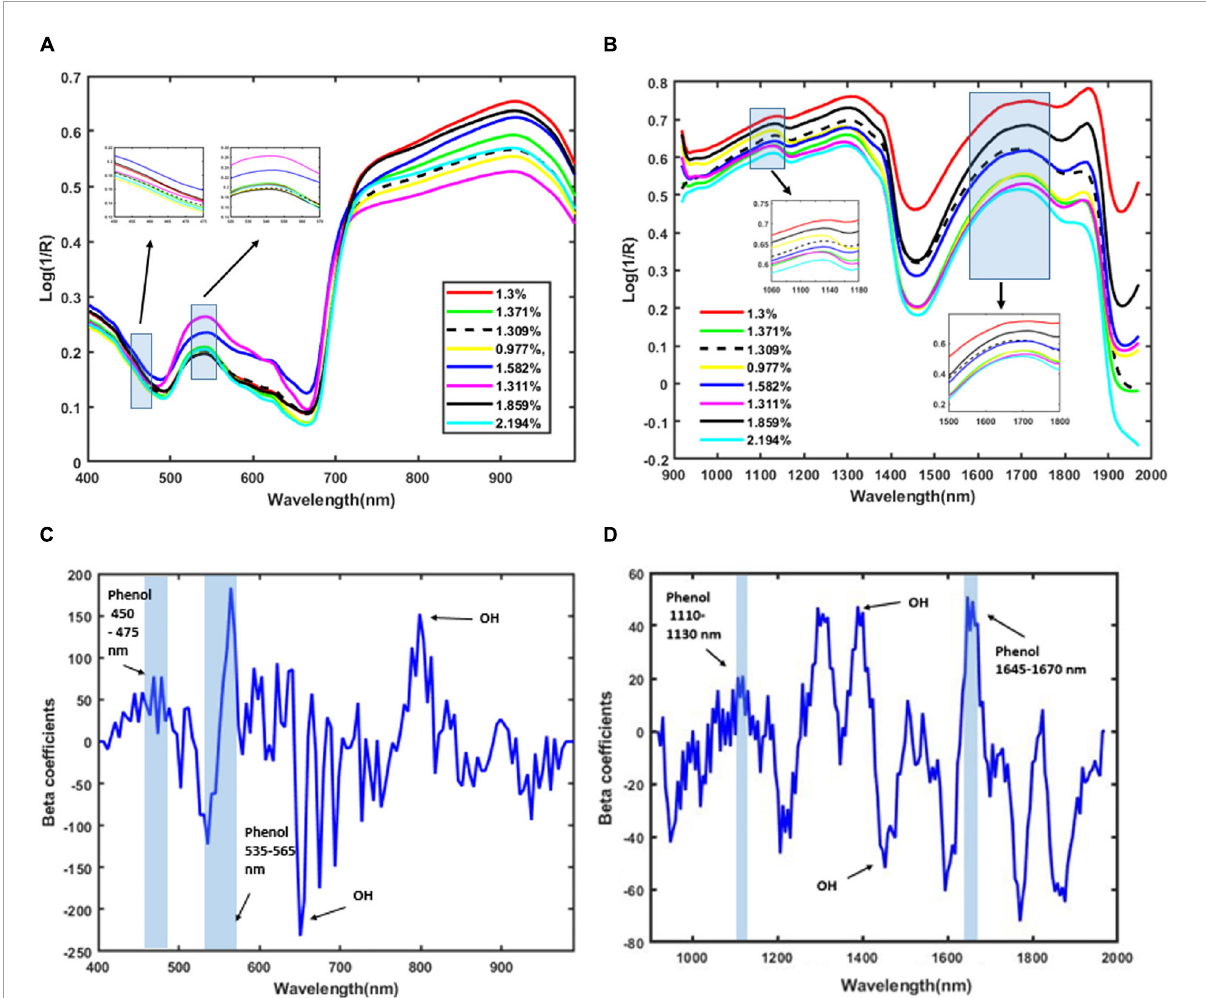
FIGURE3 Mean of pre-processed spectra using the second Savitzky–Golay derivative of plants based on total phenolic content. (A) VIS/NIR spectra, (B) SWIR spectra, (C) beta coefficients for VIS/NIR spectra, and (D) beta coefficients for SWIR